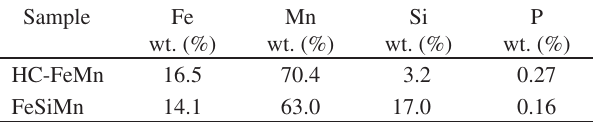
Table 1. Chemical analysis of manganese alloys fines above 1.18 mm.